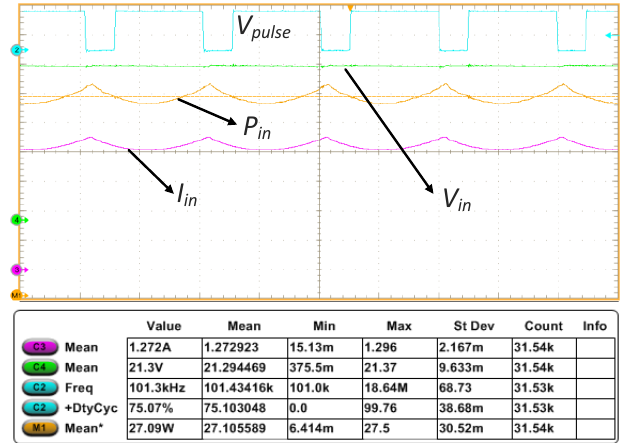
Figure 15. Input voltage and current graph.